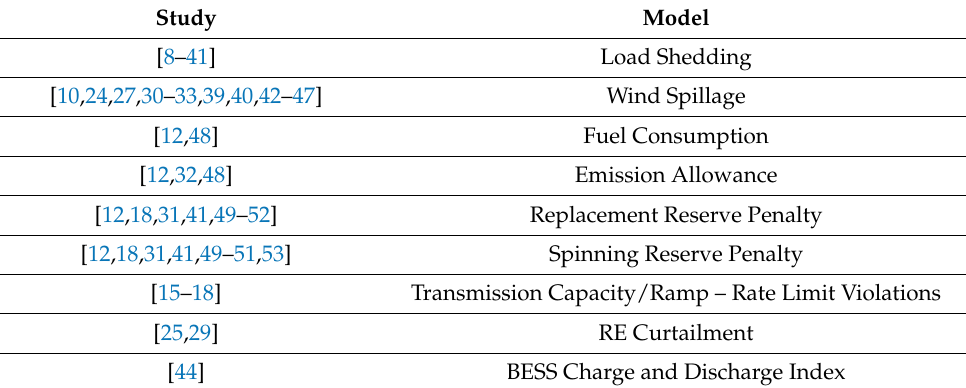
Table 1. Different Models of Penalty Cost (Social Welfare)